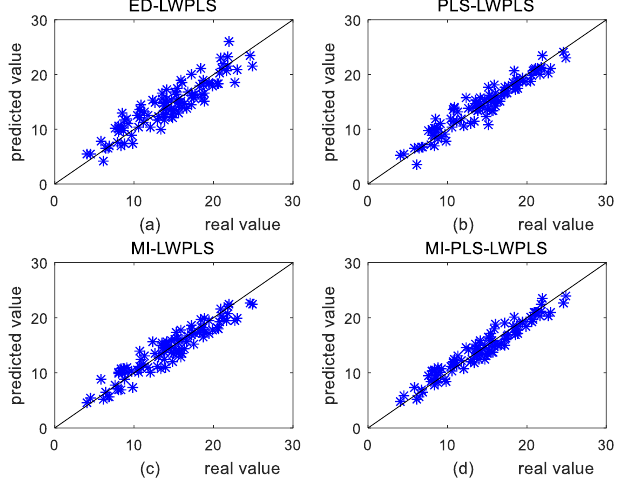
Figure 3. Comparison of prediction scatter plots in case 2: ( a ) Euclidean distance-based locally weighted partial least squares (ED-LWPLS); ( b ) PLS-LWPLS; ( c ) mutual information (MI)-LWPLS; ( d ) MI-PLS-LWPLS.